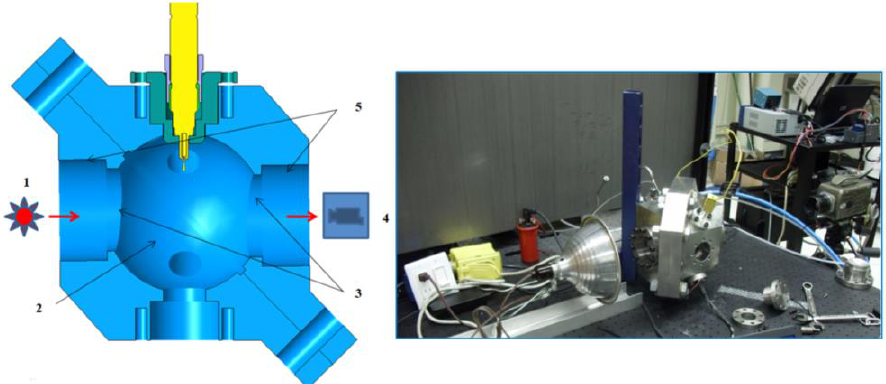
Figure 12. Pilot ignition optical chamber, diameter fused silica plugging windows: 1—Light source; 2—Spherical combustion chamber; 3—Visualization chambers; 4—High speed video camera; 5—Transparent